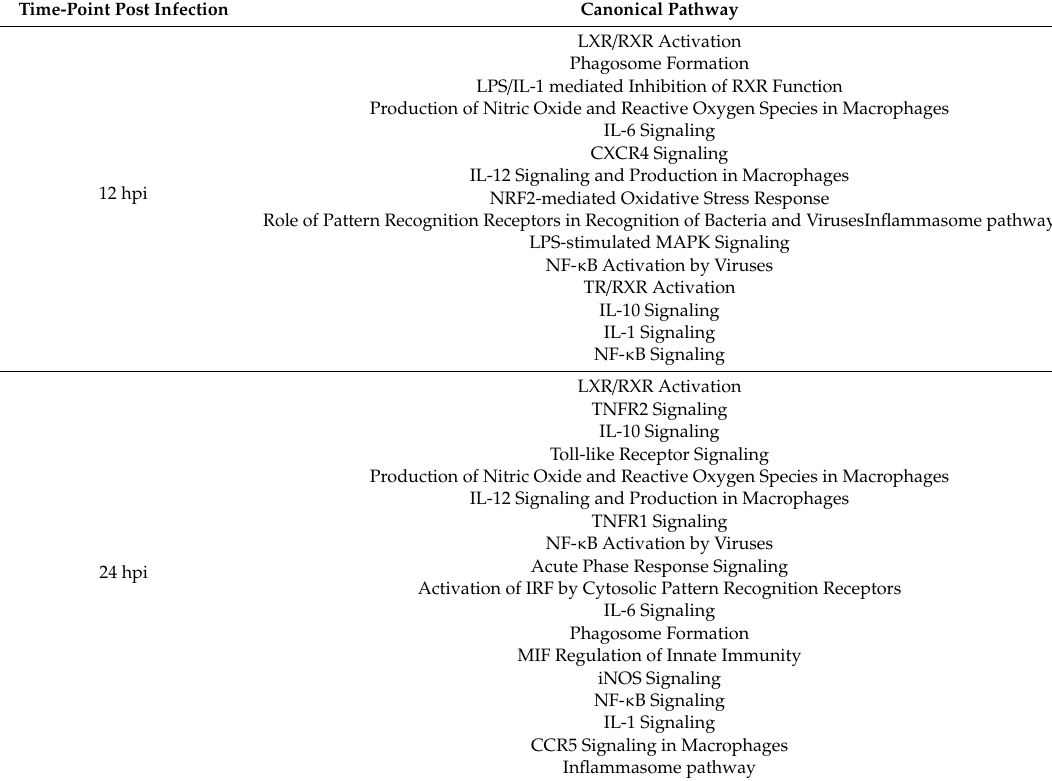
Table 1. The top canonical pathways altered in Porcine Reproductive and Respiratory Syndrome Virus (PRRSV)-infected porcine alveolar macrophages (PAMs) in